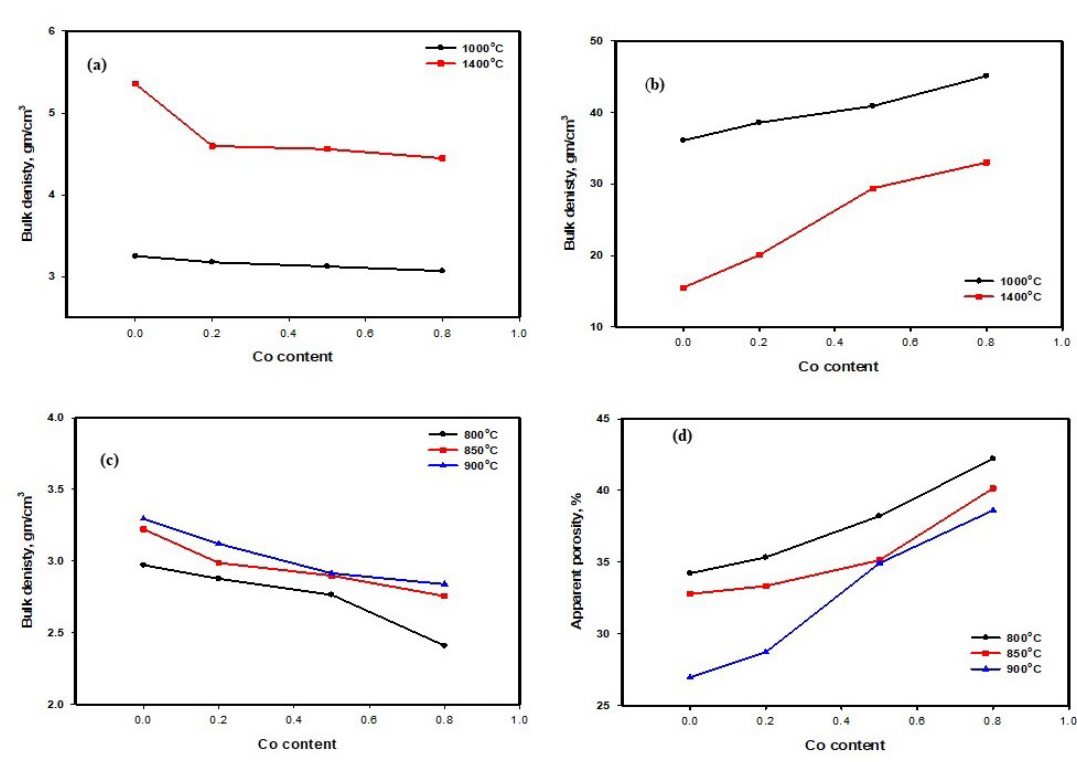
Figure 5. Apparent porosity and bulk density at different temperatures for (a, b) microwave samples and (c, d) for solid state